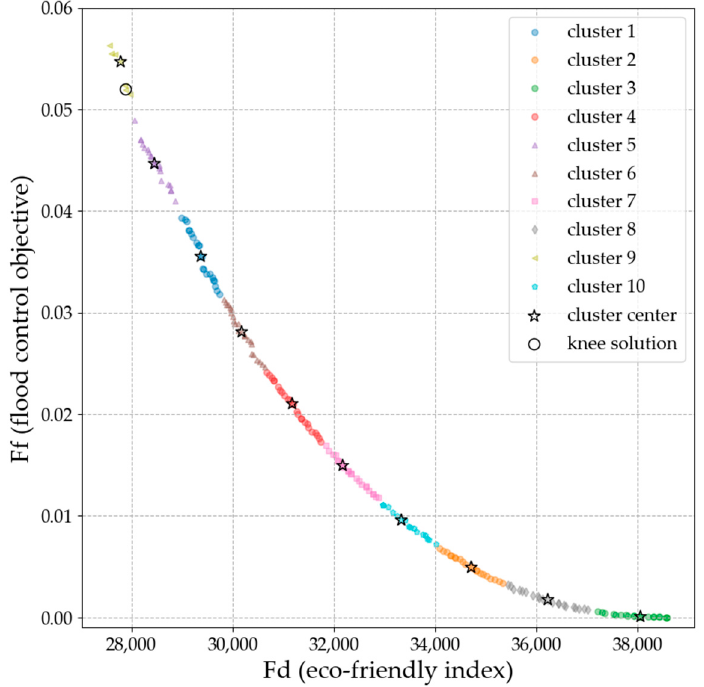
Figure 7. Schematic diagram of the clustering results in objective space.